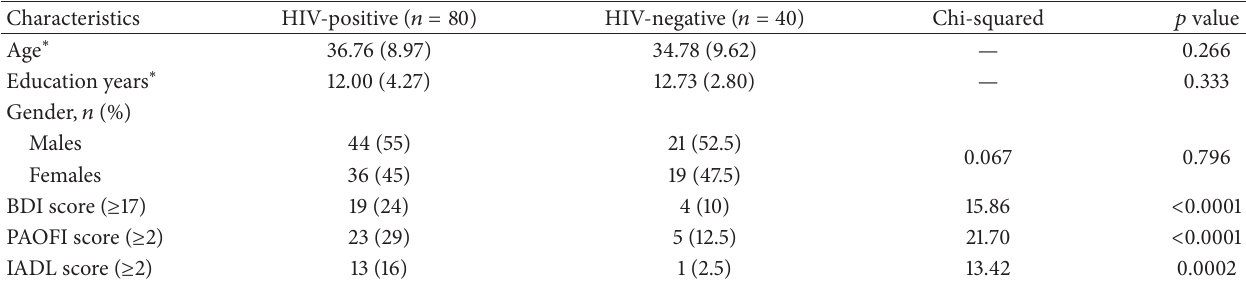
Table 1: Characteristics of the study participants.